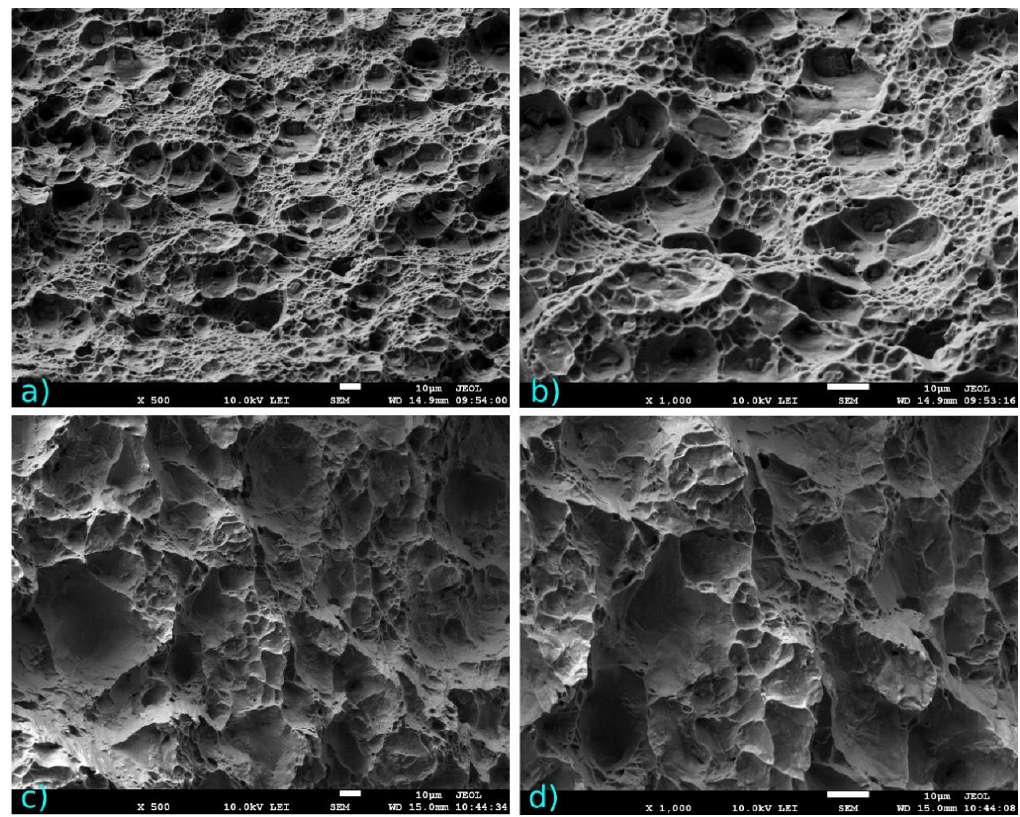
Figure 18. SEM images of the fracture surfaces of ( a ) weld no. 1; ( b ) a higher magnification of ( a ); ( c ) weld no. 5; ( d ) a higher magnification of ( c